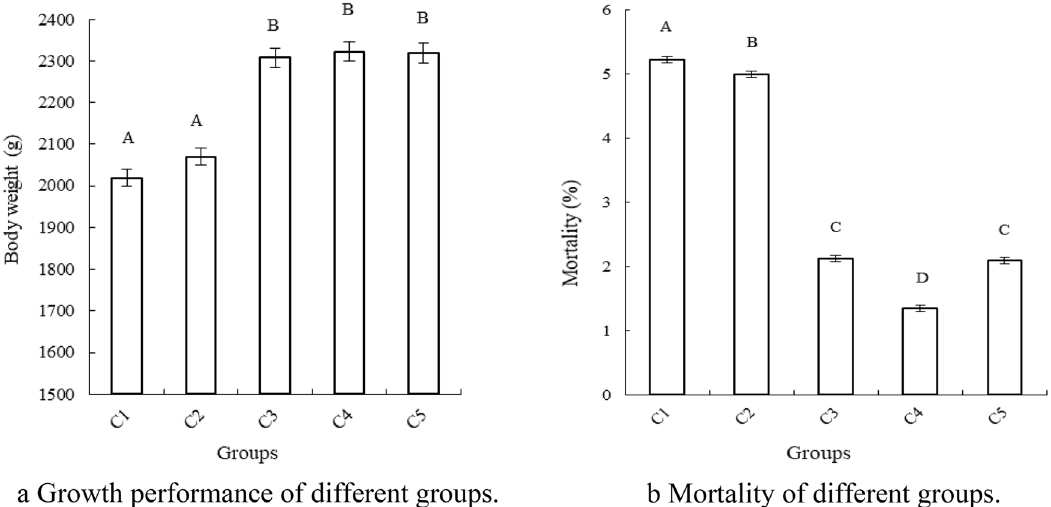
Figure 1. Chicken growth performance and mortality. Chicks fed control (C1), or with SS (C2), BS (C3), SEBS (C4) and flavomycin (C5) supplementation and growth performance ( a ) and mortality ( b ) of each group was measured. Data was statistically processed as repeated measurements. Superscript capital letters in columns mean P < 0.01. The Microsoft Office Excel 2010 was used to as the stamp